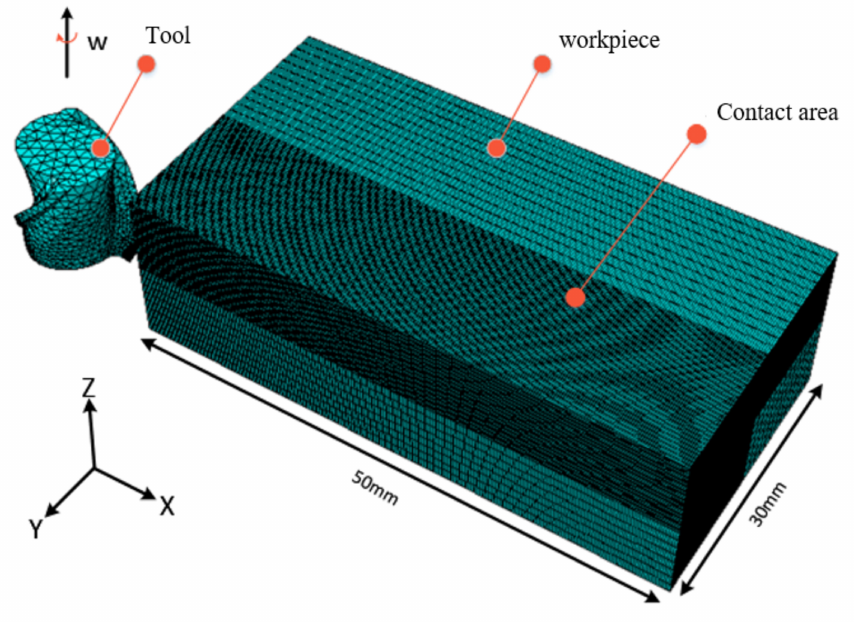
Figure 3. Finite element simulation